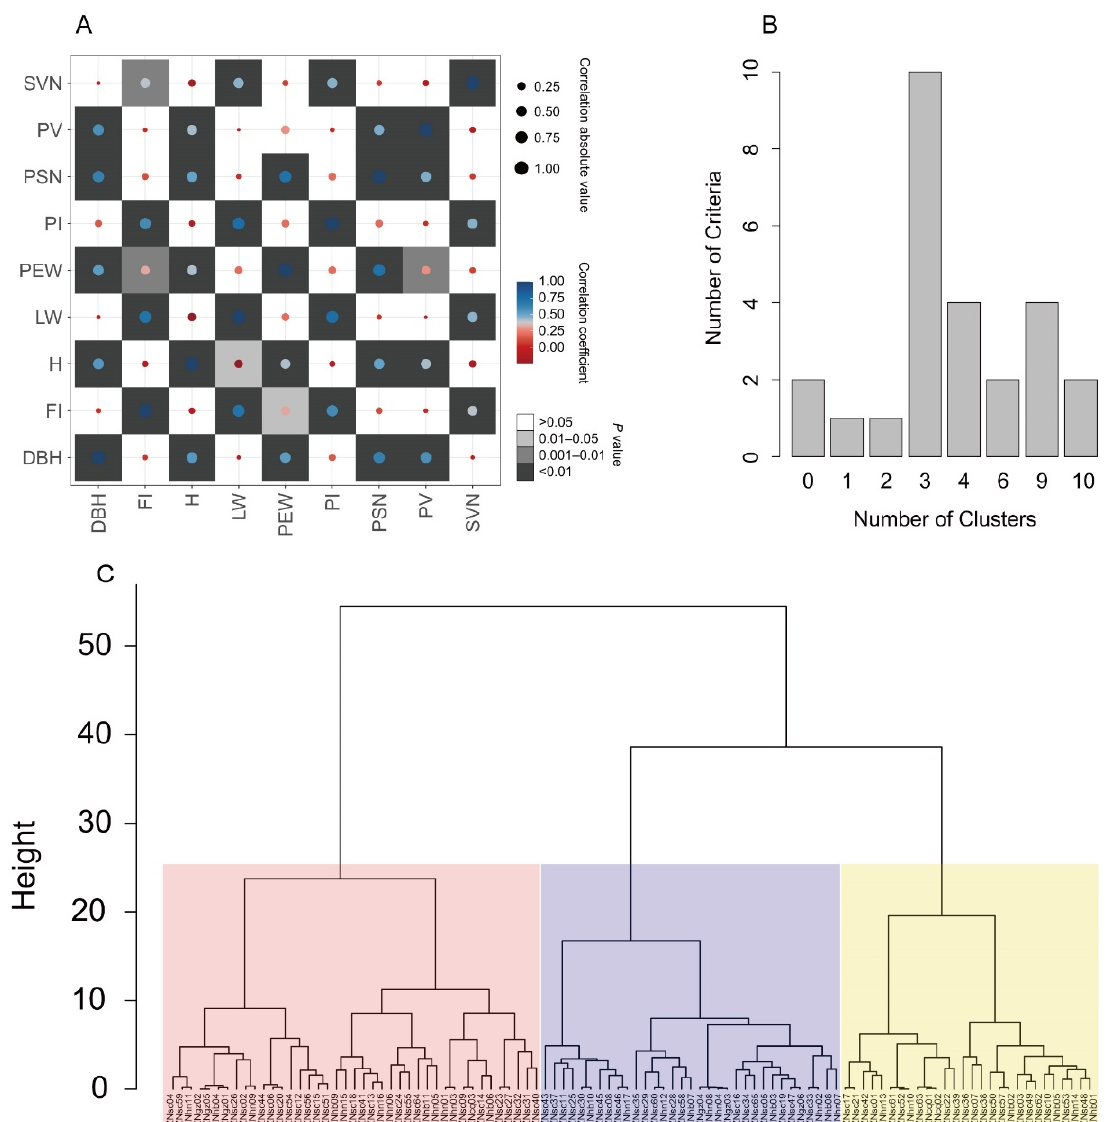
Figure 3. Correlation analysis among phenotypic traits ( A ) and ward cluster analysis ( B , C ) of P. zhennan breeding population. H, height; DBH, diameter at breast height; PSN, south-north crown diameter; PEW, east-west crown diameter; PV, piloydn value; FI, leaf length; LW, leaf width; PI, petiole length; SVN, the number of secondary veins; abs_cor means correlation absolute value; and value means correlation coefficient. The different colors (red, blue, and yellow) in the dendrogram represent three different groups which were divided by Euclidean distance.